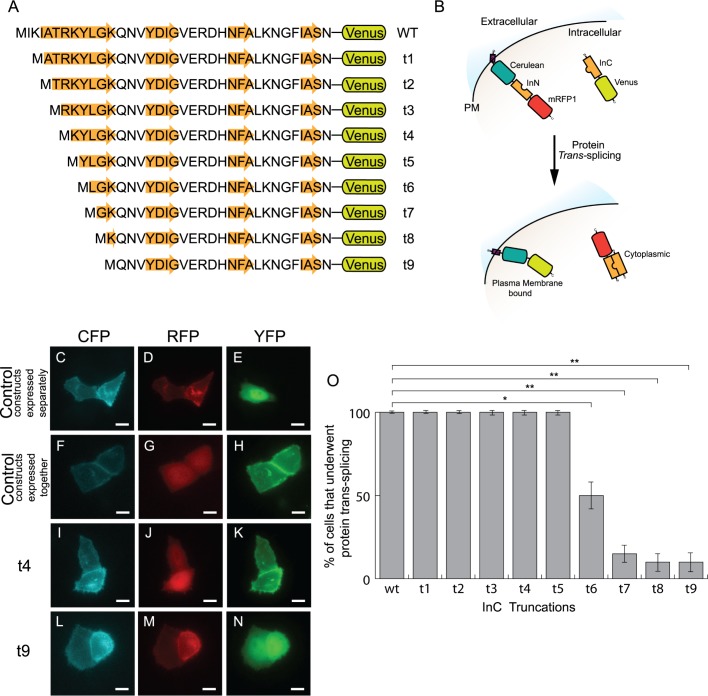
Determining the minimal functional NpuDnaEC intein with PTS activity in mammalian cells.(A) Protein sequence of systematic truncations of the first N-terminus β-strand of NpuDnaEC intein. (B) Schematic diagram of constructs used for establishing PTS activity, where Lyn is a plasma membrane (PM) localization sequence (shown in purple). Successful PTS activity would result in Cerulean and Venus localized to the PM while mRFP would be localized to the cytoplasm. HeLa cells expressing M-Cerulean-InN-mRFP resulted in (C) CFP and (D) RFP fluorescence localized to the PM. (D) Expression of InC-Venus resulted in YFP fluorescence distributed in the cytoplasm. Co-expression of the two constructs triggered PTS activity resulting PM localization of (F) CFP and (H) YFP while the cytoplasm is (G) RFP fluorescence. Co-expression of M-Cerulean-InN-mRFP with (I-K) t4 and (L-N) t9 truncations of N-terminus of InC in HeLa cells shown in CFP, RFP and YFP fluorescence, respectively. (O) The percentage of co-transfected cells with truncated mutants of InC (n = 6 experiments with over 20 cells). β-strands are shown in orange arrow. Comparison between wild-type: *p < 0.005, ** p < 0.001. Error bars are standard deviation. Scale bars are 10 μm. Images are in false colour.